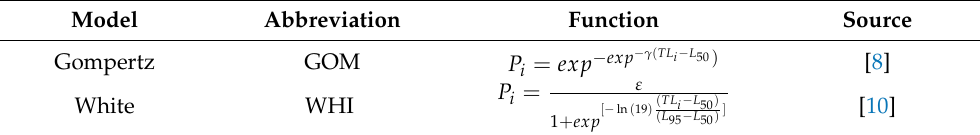
Table 1. Candidate length-at-maturity models used to estimate L 50 for Narcine entemedor